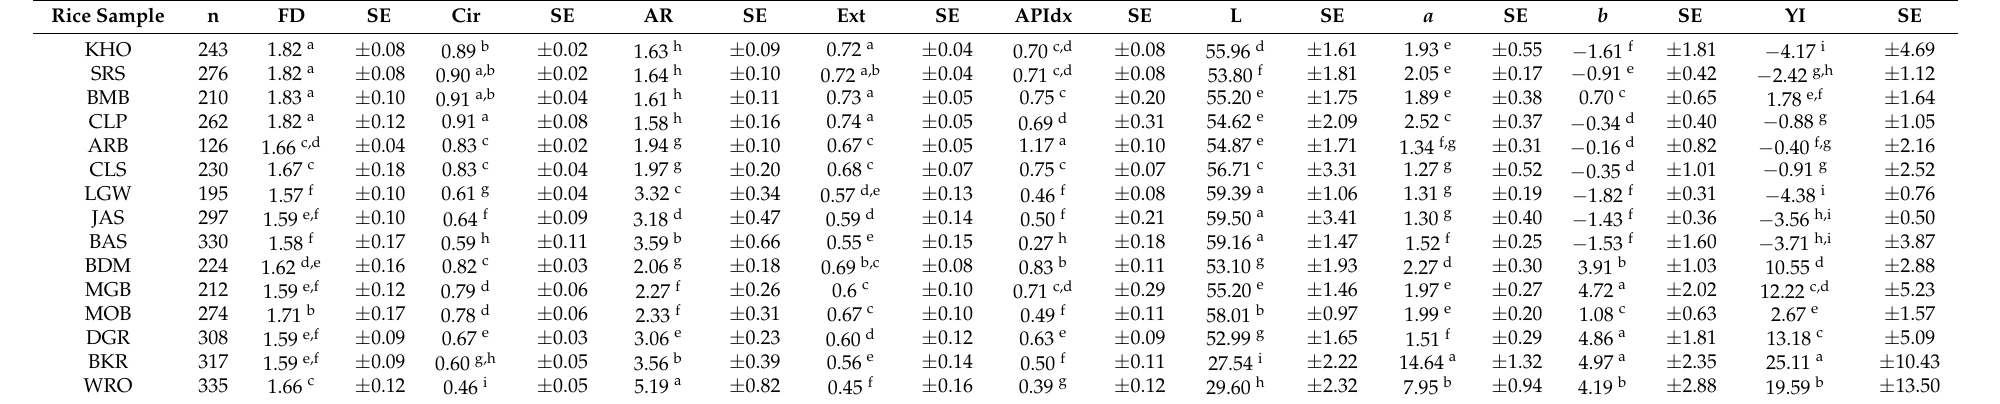
Table 3. The mean and ± standard error (SE) values for morpho-colorimetric parameters of the commercial rice